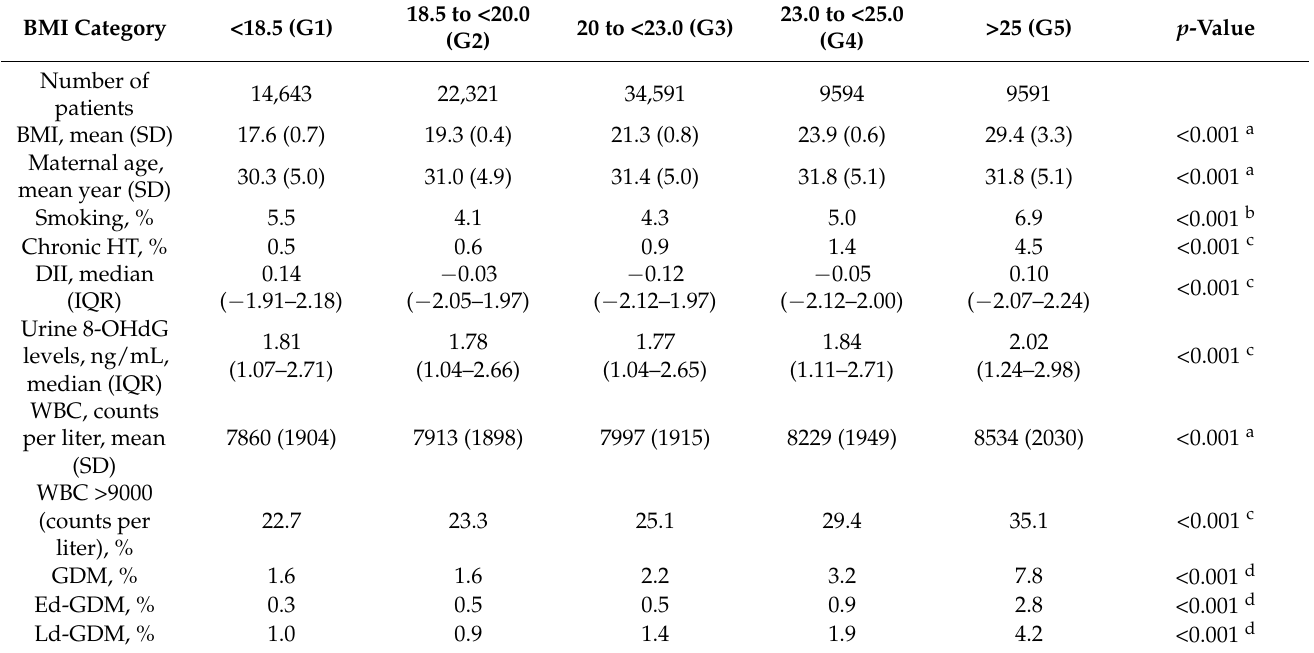
Table 2. Maternal background and obstetrics outcomes according to body mass index (BMI) before